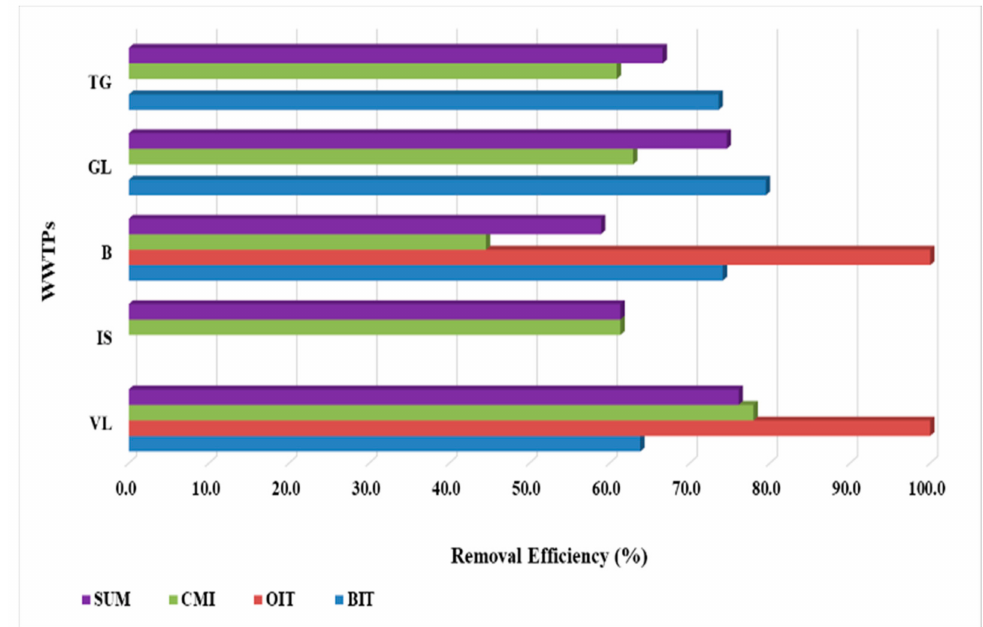
Figure 3. WWTPs removal capacity calculated for both individual compounds and for the sum of